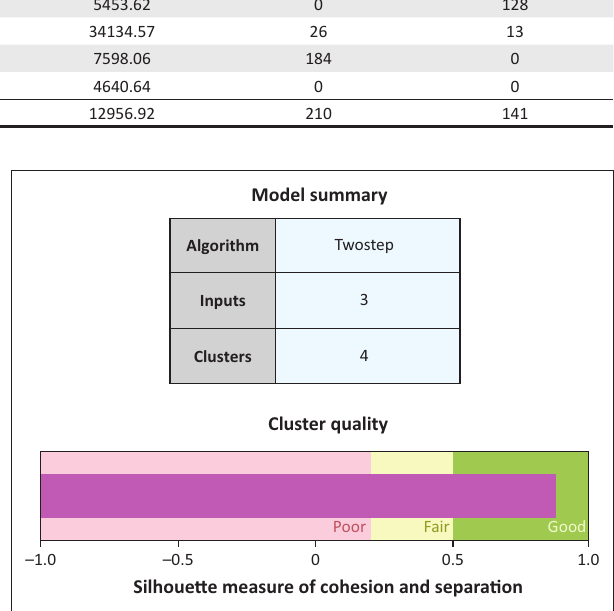
FIGURE 3: Model summary.